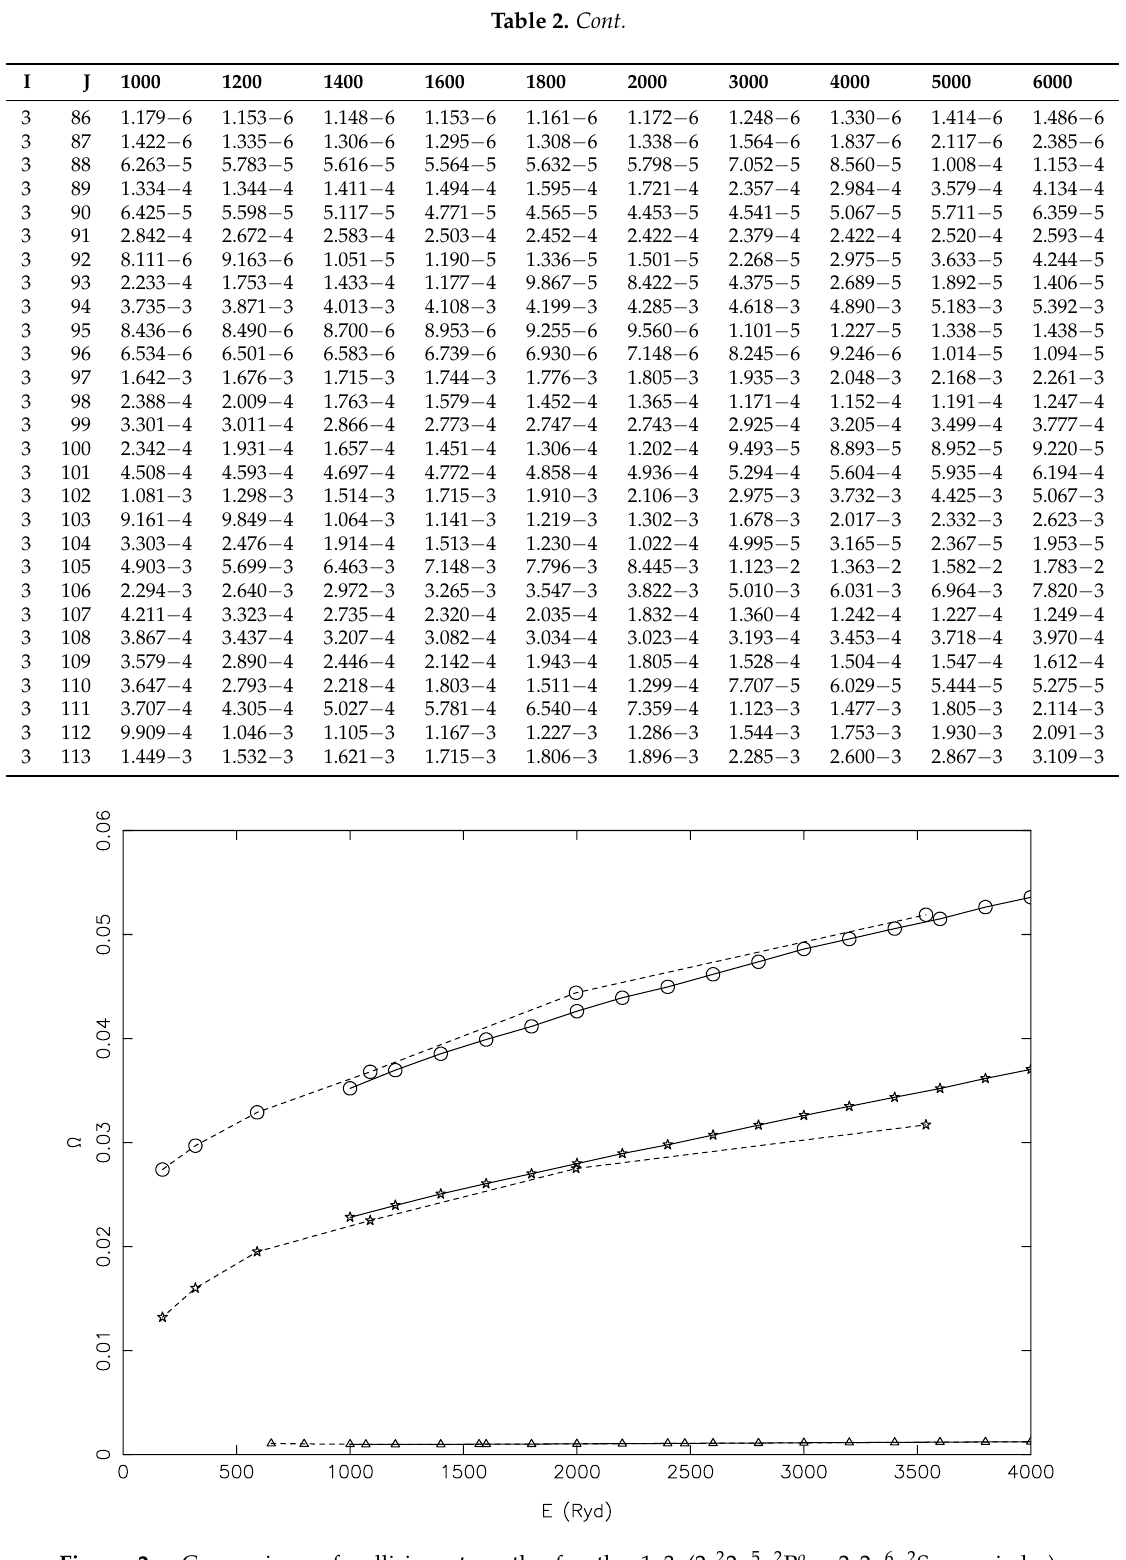
–2s2p 6 2 S 1/2 : circles), 3/2 –2s2p 6 2 S 1/2 : stars) transitions 1/2